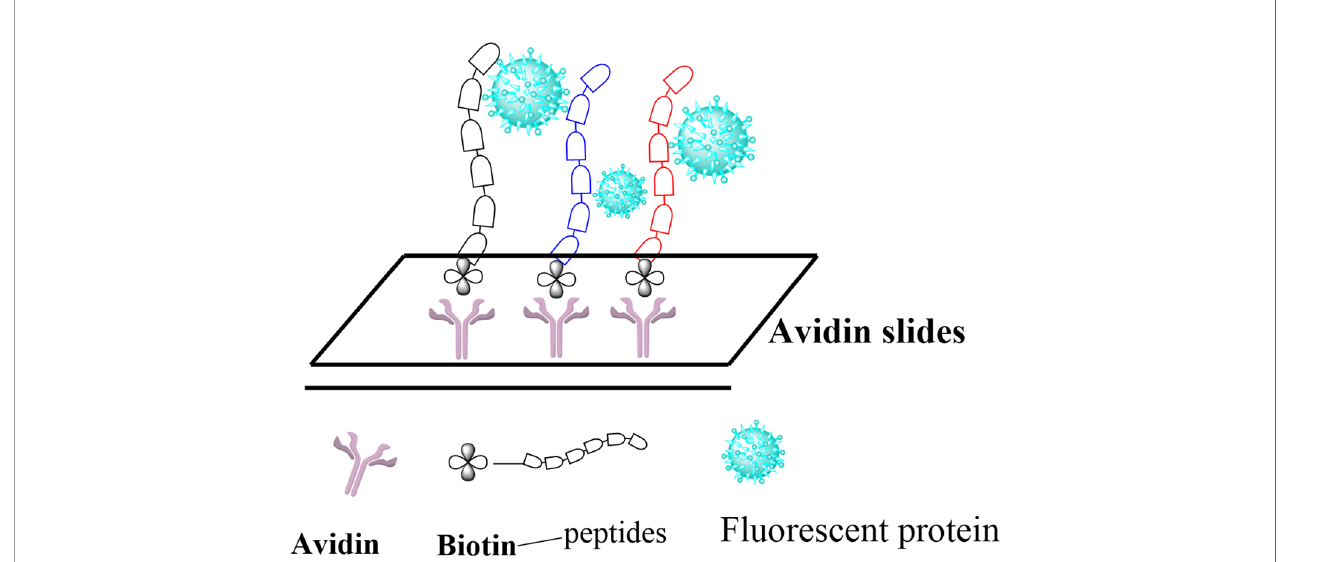
FIGURE 1 | Overall screening work fl ow of the different acylated histone peptides by